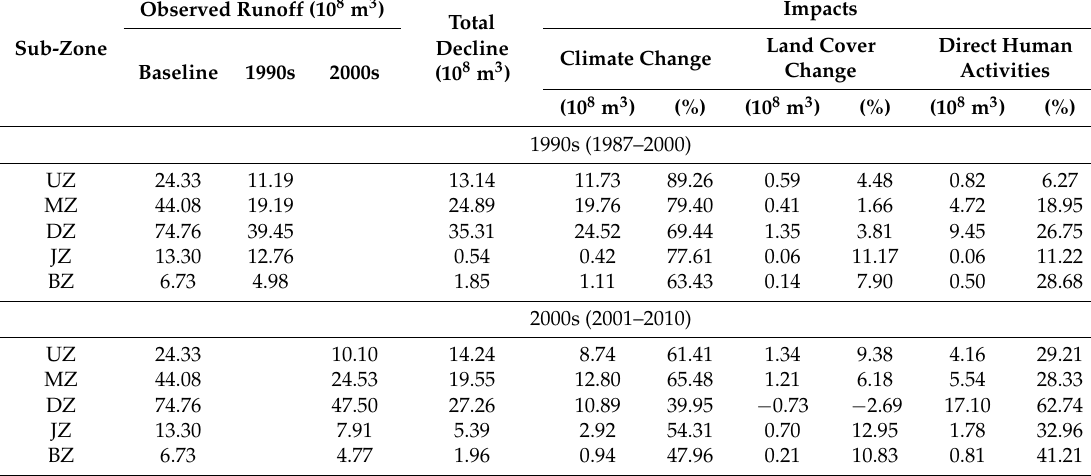
Table 10. Impacts of climate, land cover change and direct human activities on